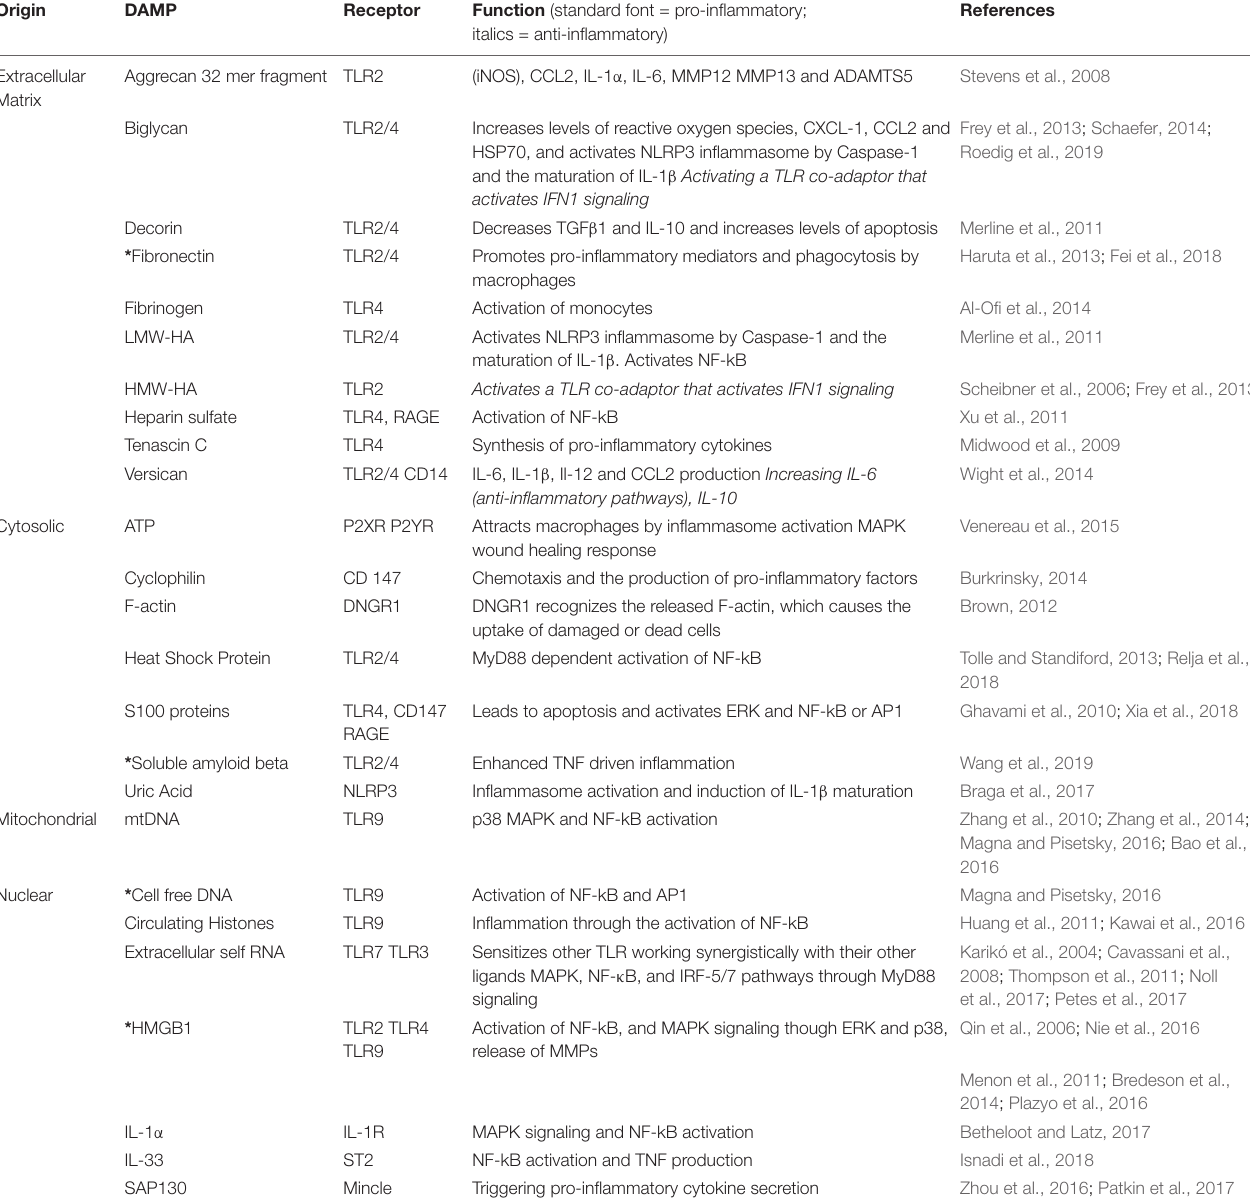
TABLE 1 | Summary of key Danger Associated Molecular Patterns, their receptors and